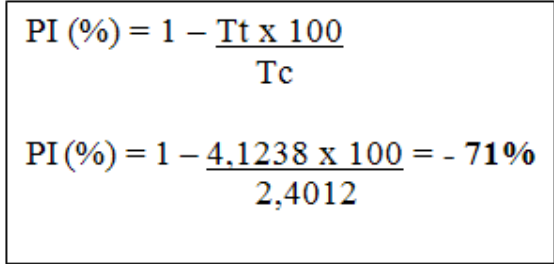
FIGURE 4 – Result of the Tarnowisk and Stock equation applied to this